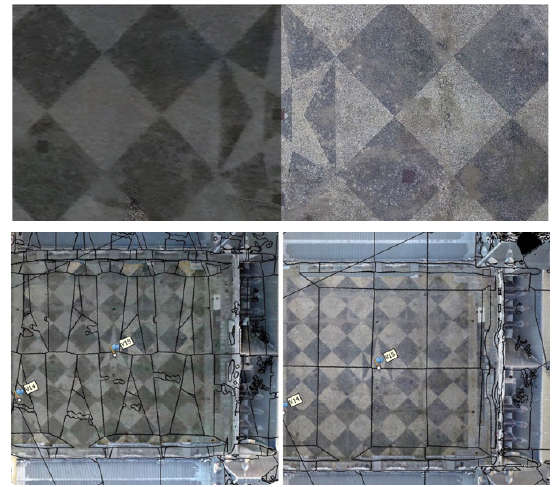
Figure 12. Radiometric difference between the orthophoto generated from spherical images (top left) and nadir images only (top right). The seamlines on the orthophotos have a more irregular pattern when 360° images are used (bottom left) compared with only nadiral (bottom right).